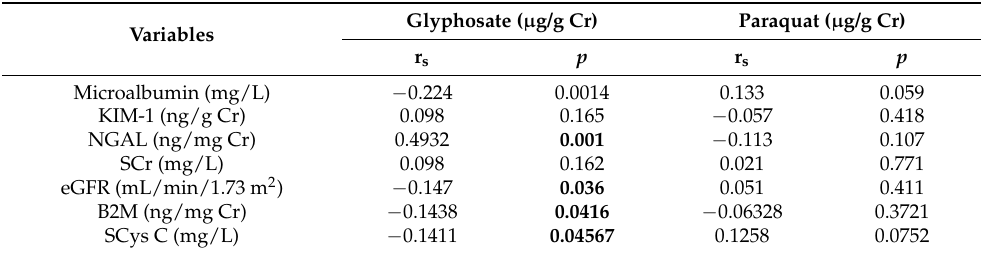
Table 4. Associations between Microalbumin, ACR, serum creatinine, eGFR, urinary biomarkers KIM-1, NGAL with urinary glyphosate and paraquat residues.